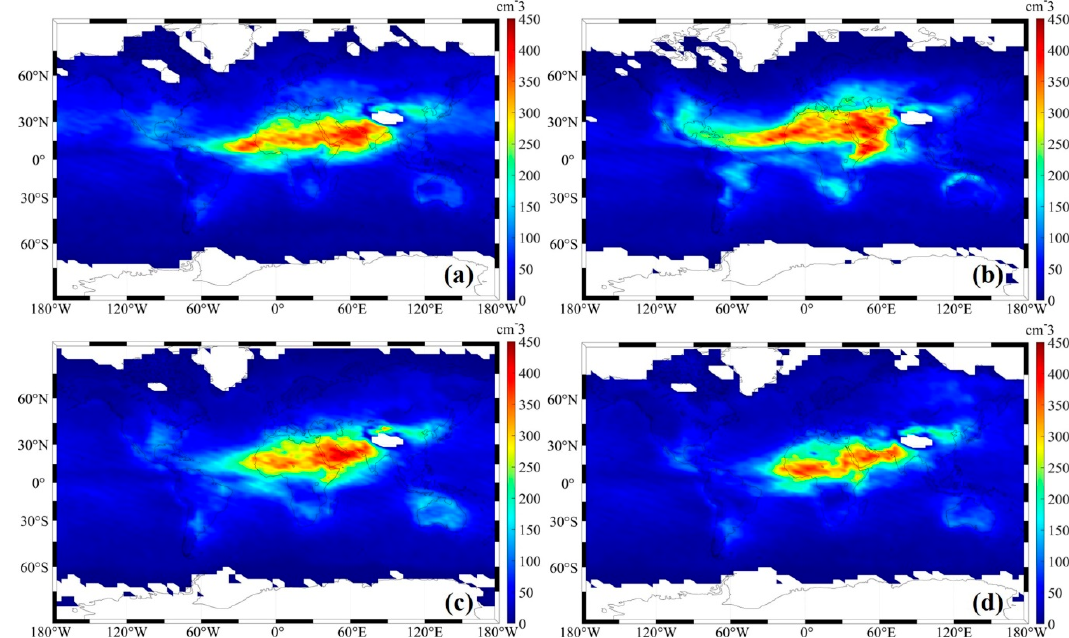
Figure 2. Spatial distributions of seasonal dust aerosol MFNC averaged from 2006 to 2016. ( a ) Spring; ( b ) summer; ( c ) autumn; ( d ) winter. White area indicates no data. It should be noted that the scale of color bars are different from each other. Remote Sens. 2020 , 12 , x FOR PEER REVIEW